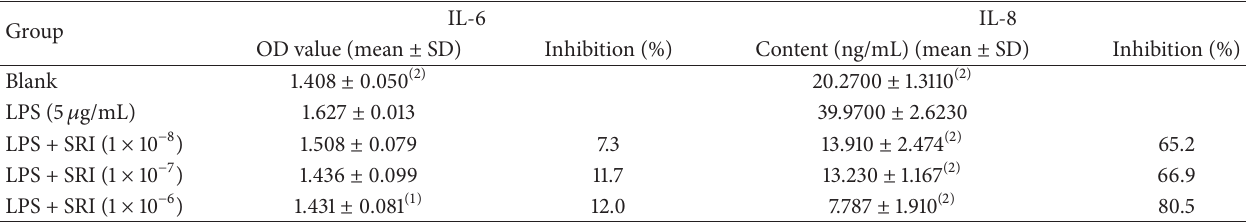
Table 2: The influences of SRI on carrageenin-induced mouse paw edema model (𝑛 = 20) . Dosage Difference between left and Group (mg/kg) right paw (mg) (mean ± SD) Model 0.083 ± 0.211 Ibuprofen 176.5 0.039 ± 0.009 ( 1 ) 53.01 SRI (LD /5) 48.60 0.057 ± 0.010 ( 1 ) 31.32 50 SRI (LD /20) 12.15 0.058 ± 0.019 ( 1 ) 50